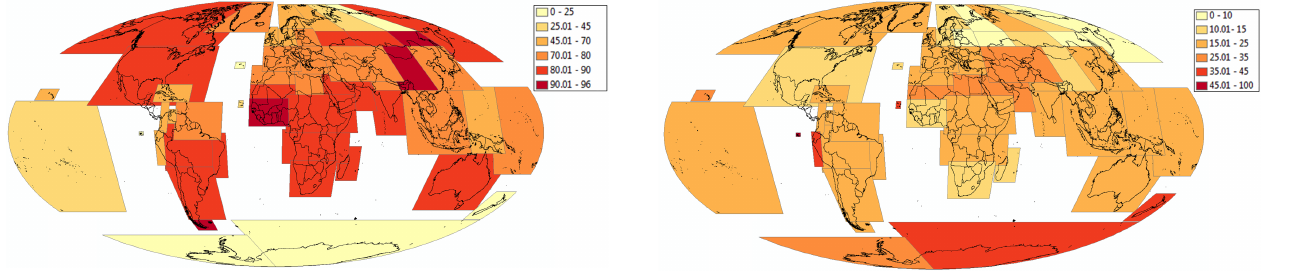
Figure 3. Percent of variance explained by cross-validated moving window regression.